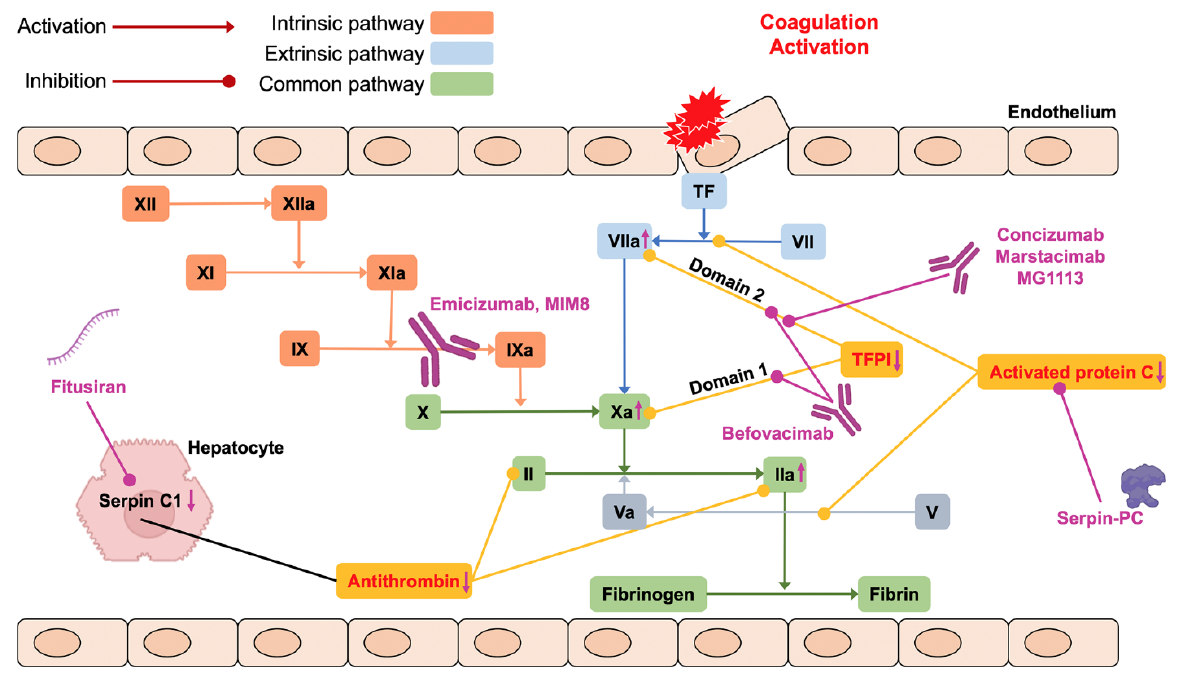
Figure 1. The mechanism of action of novel non-replacement treatments. PC = protein C; TF = tissue factor, TFPI = TF pathway inhibitor.